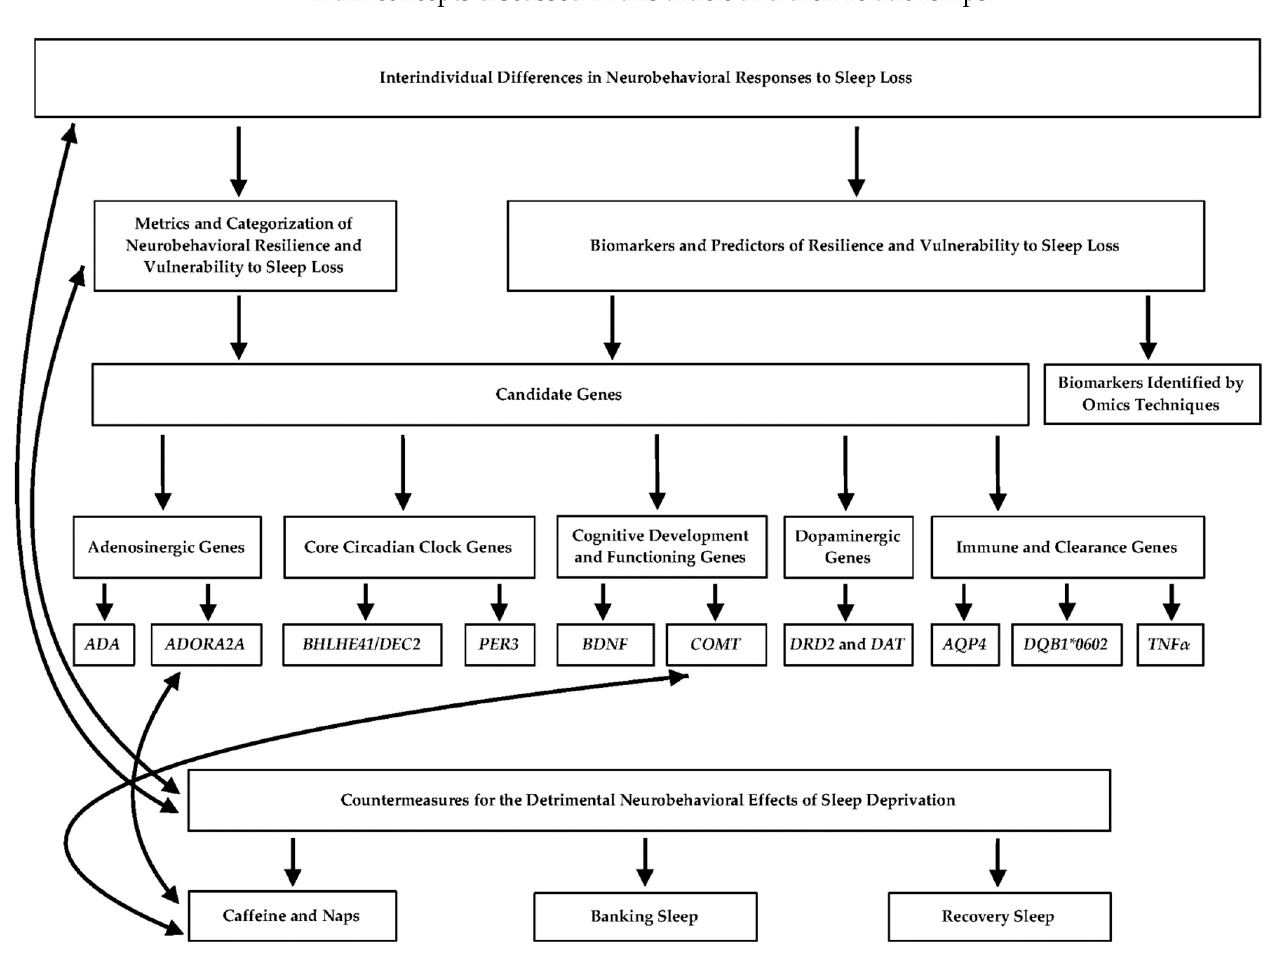
Figure 1. Flowchart depicting the relationships between the main concepts presented in the review. Solid black arrows indicate an established connection between the topics. Connections between genes and countermeasures are associative and not causal, thus warranting the need for further investigation.